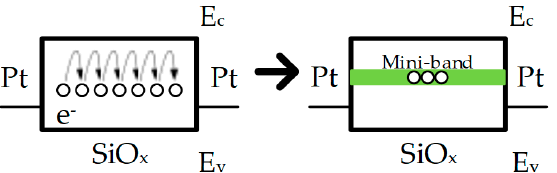
Figure 4. Schematic of discontinuous and continuous states of mini-band DBs in the middle of silicon oxide band gap.